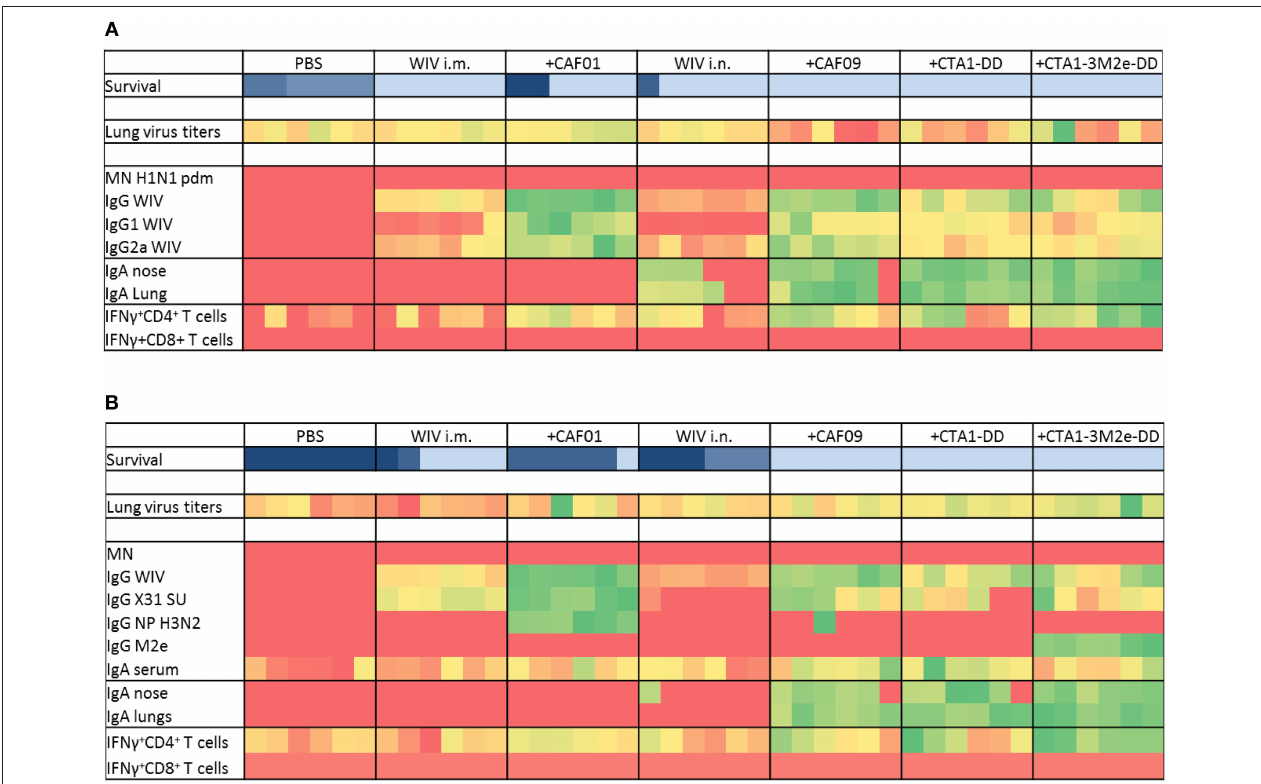
FIGURE 2 | Immunoprofiling against heterologous and heterosubtypic viruses. Animals were vaccinated 3 times with the vaccines indicated in Table 1 . After 3 vaccinations, sera, nasal, and lung washes and spleens were collected to determine systemic, mucosal and cell mediated immune responses ( n = 6). Some animals were challenged with heterologous (A) and heterosubtypic (B) virus to determine protection, lung viral load ( n = 6) and survival ( n = 6). Generated data was used as input and conditional formatting was performed in Ms Excel to plot heatmaps. Each column represents one animal. Survival is shown with different color scheme as these are different animals compared to the rest. Dark blue indicates worst survival while light blue indicates best survival. For other parameters, heatmaps range from red (lowest response) to green (best response).